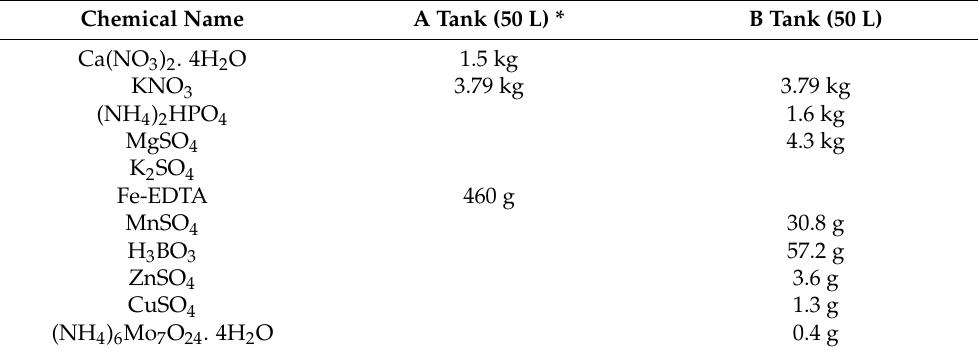
Table 2. Nutrient